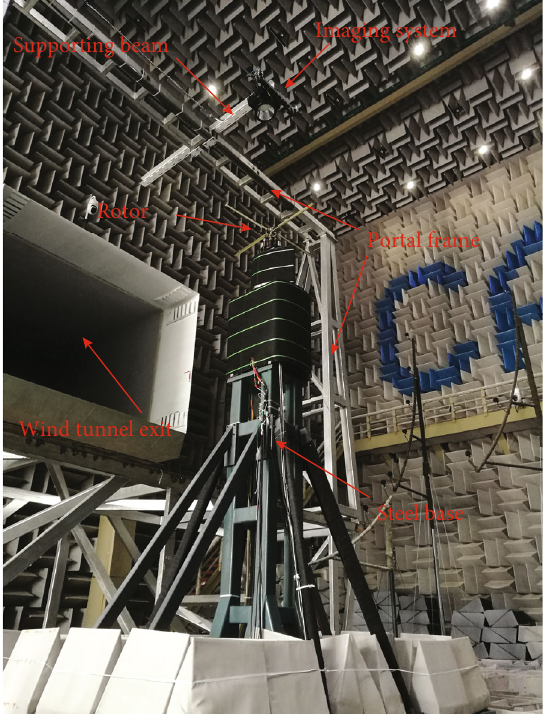
Figure 6: Overview of the experimental installation.